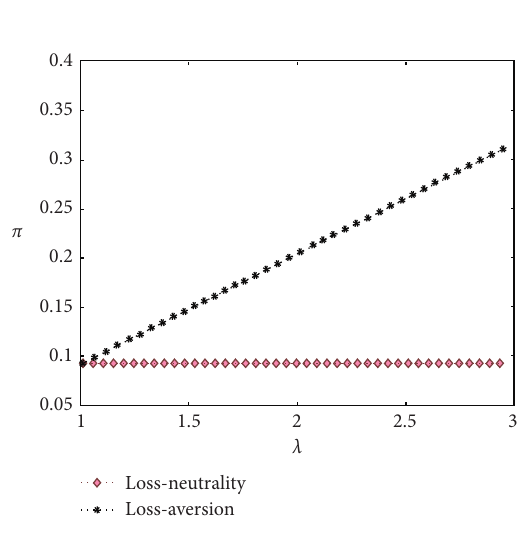
Figure 8: Effect of θ on π .